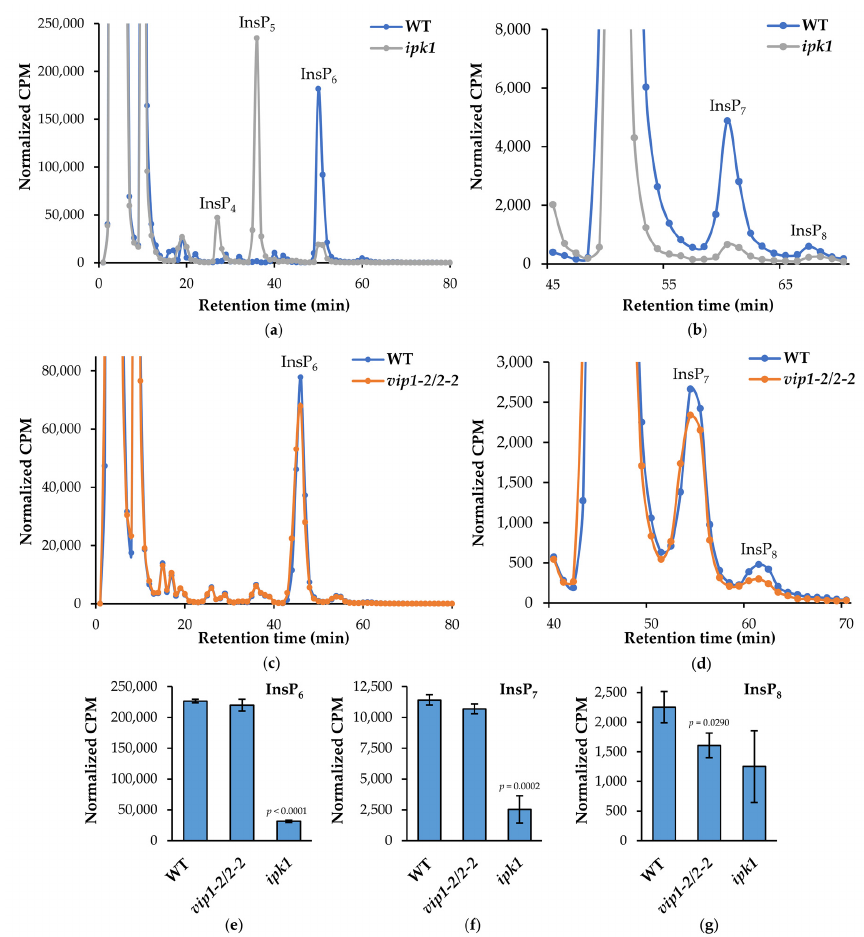
Figure 6. Inositol phosphate profiles. Fourteen-day-old WT, vip1-2 / vip2-2 and ipk1 seedlings were radiolabeled with 3 H- myo- inositol for 5 days and InsP species were separated by HPLC and quantified by liquid scintillation counting. ( a – d ) Normalized CPM elution profiles comparing WT to ipk1 ( a , b ) and vip1-2 / vip2-2 ( c , d ). ( e – g ) Normalized CPM from fractions comprising InsP 6 ( e ), InsP 7 ( f ), and InsP 8 ( g ). Mean values of three replicate experiments are shown ( n = 3) and error bars represent standard deviation. Significance of differences relative to WT were calculated by two tailed Student’s t